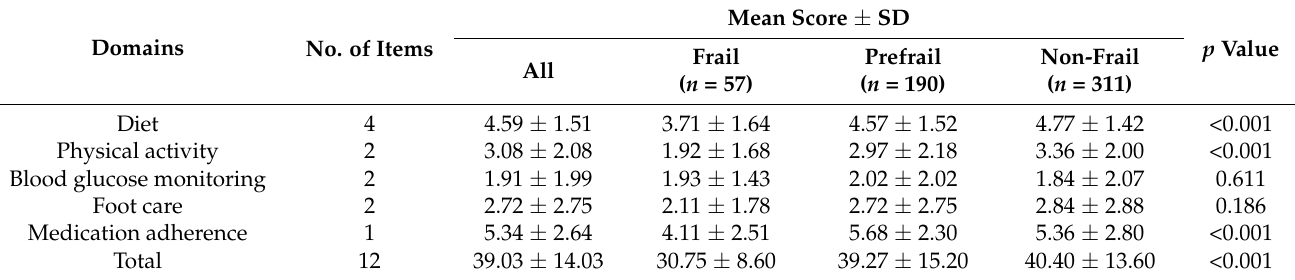
Table 2. Scores of the Summary of Diabetes Self-Care Activities (SDSCA) measure of participants ( n = 558).